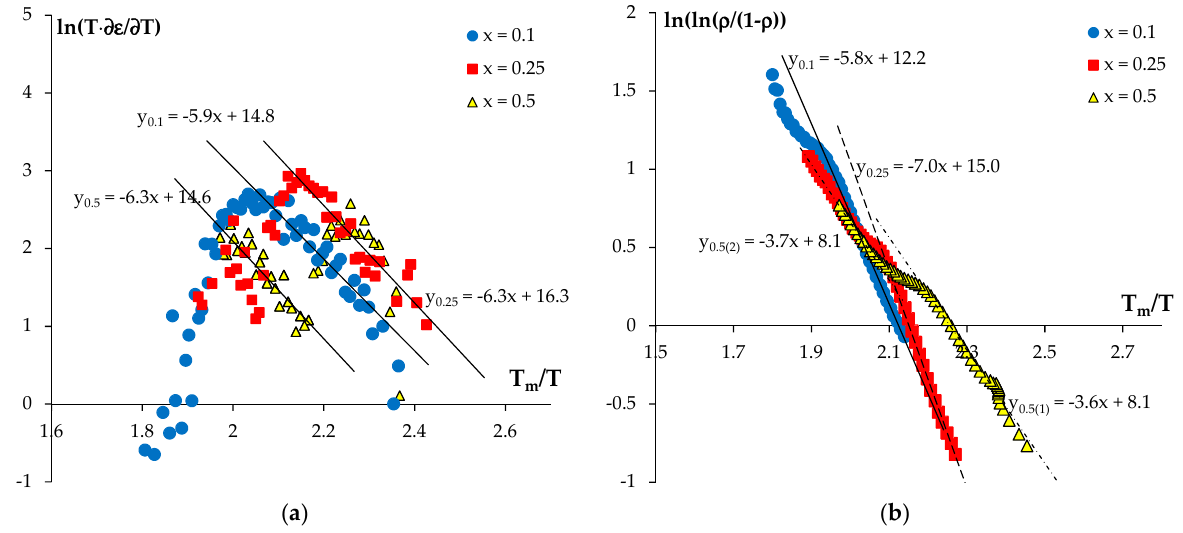
Figure 11. ln(T ∂ ε / ∂ T) − T m /T ( a ) and ln(ln( α · ρ /(1 − ρ )) − T m /T ( b ) curves for Na 1+2x Zr 2 − x Co x (PO 4 ) 3 ceramics with varying cobalt content (x = 0.1, 0.25, 0.5). Determination of SPS activation energy at the stage of intense powder shrinkage.